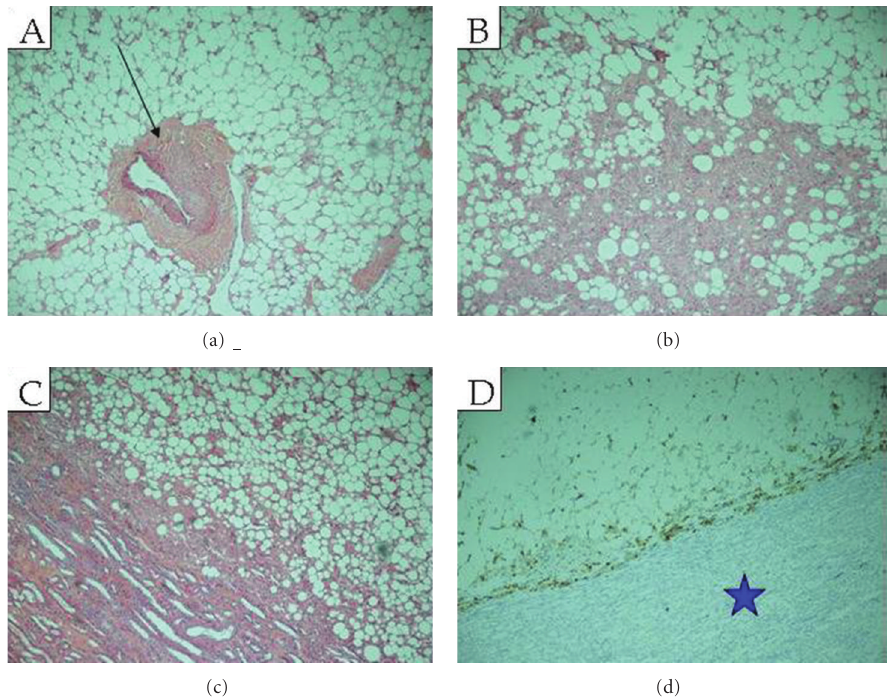
Figure 4: Extrarenal mass (Hematoxylin and Eosin). Photomicrograph of the mass demonstrate mature adipose tissue with a tortuous thick blood vessel (black arrow) ((a); × 20) and bundles of smooth muscles lacking elastic tissue lamina ((b); × 40), adipose tissue with small areas of smooth muscle with epithelioid features ((c); × 40). Focal staining with HMB45 antibody was positive (blue star) ((d); × 40), consistent with